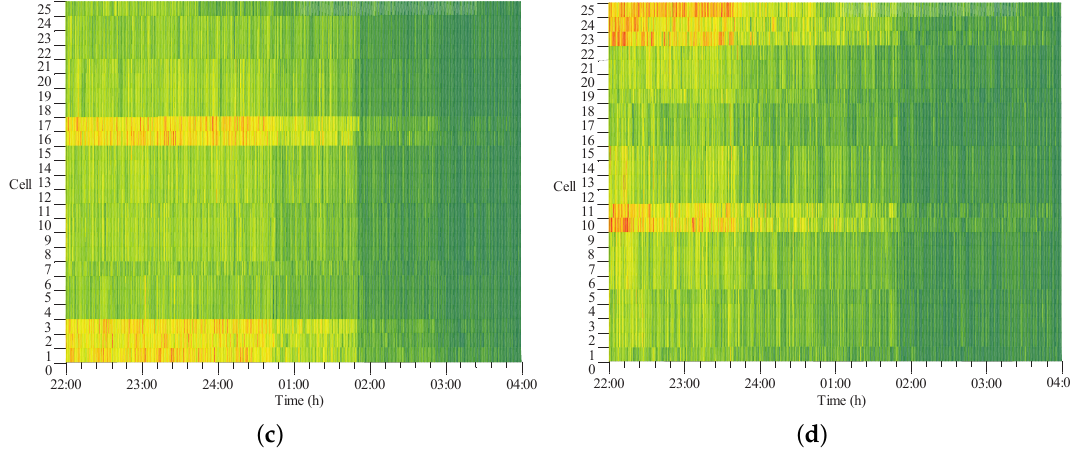
Figure 4. Estimated densities. ( a ) Subsystem 1; ( b ) Subsystem 2; ( c ) Subsystem 3; ( d ) Subsystem 4.